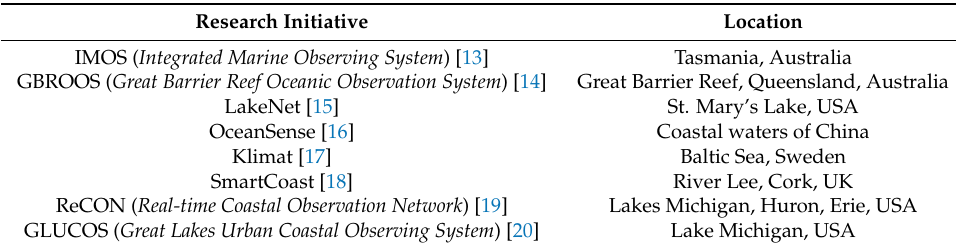
Table 1. Research-Based Water Quality Monitoring Initiatives.